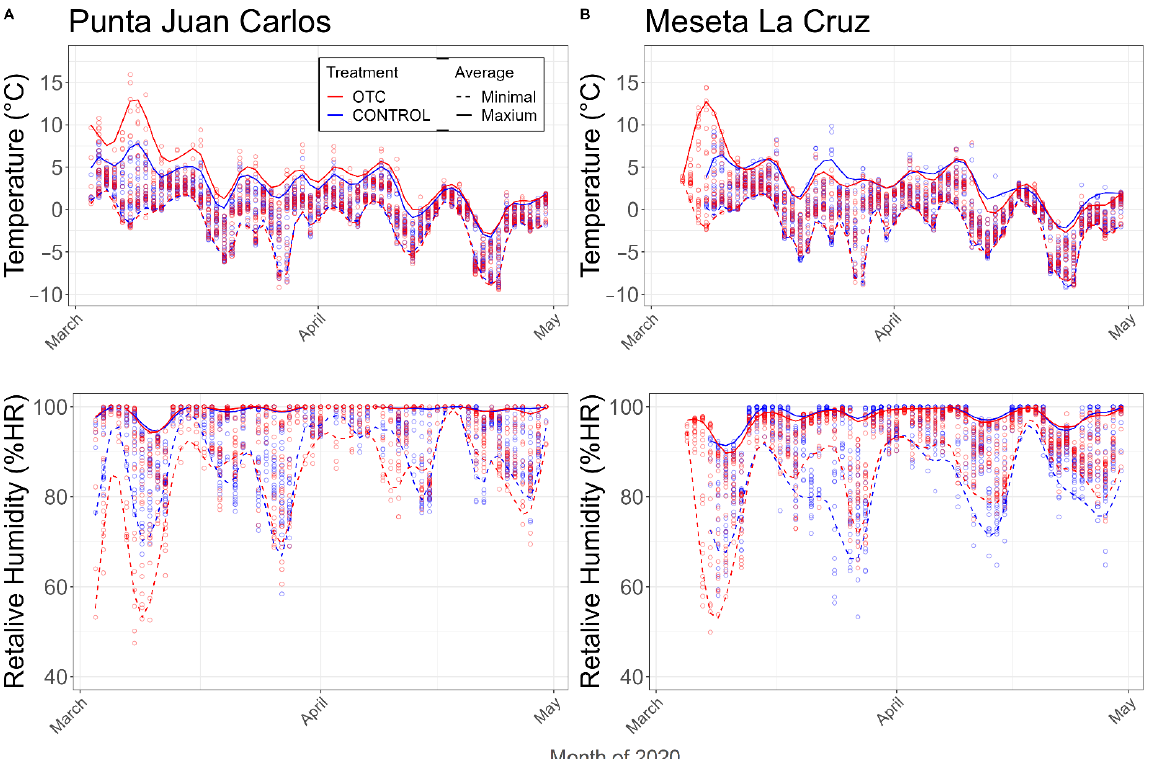
Figure 1. Temperature (°C) and relative air humidity recorded at ( A ) Punta Juan Carlos and ( B ) Meseta La Cruz, Fildes Peninsula, King George Island. Measurements from March to April 2020. The envelope curves are cubic splines fitted through the minima and maxima temperatures of data collected inside (OTC) and outside (control) of open top chambers, and every 2